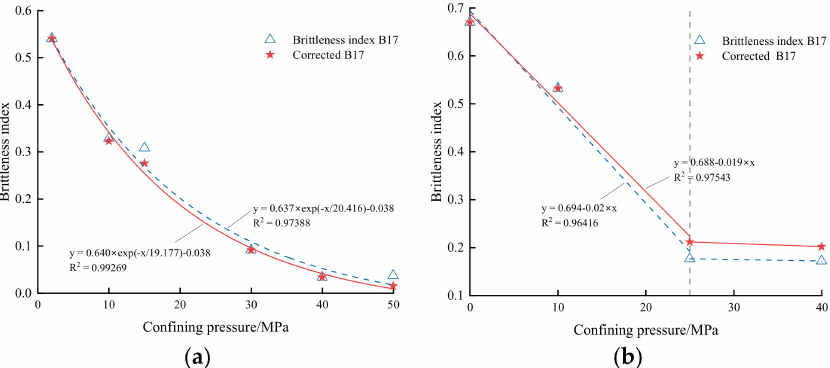
Figure 6. The change of brittleness index B 17 and modified brittleness index with confining pressure. ( a ) Marble, ( b )